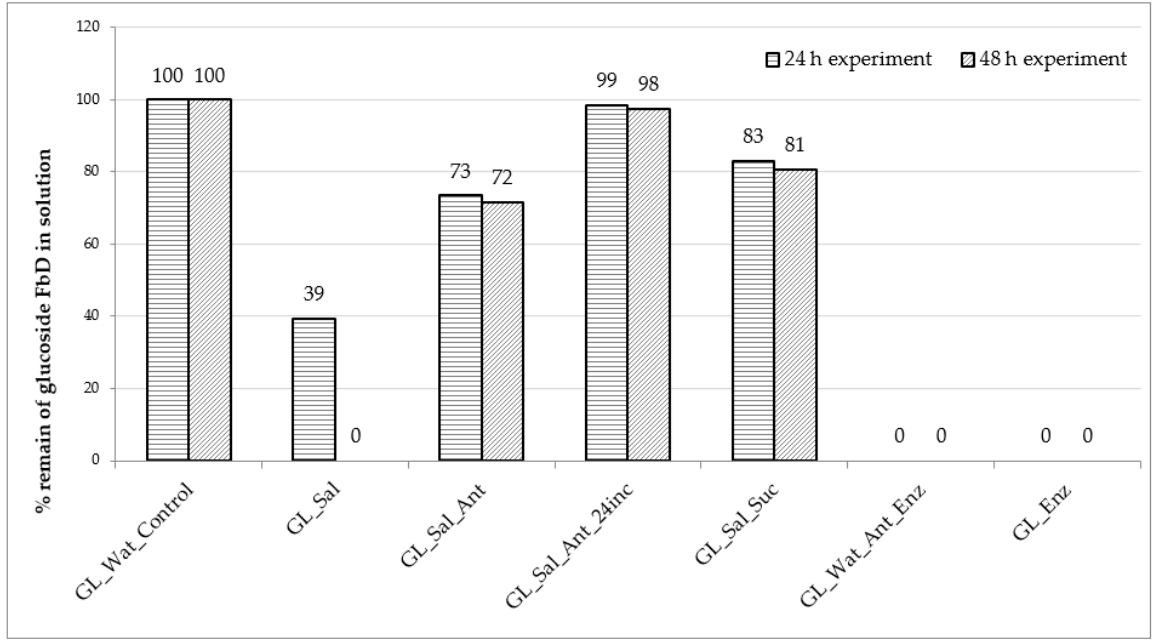
Figure 6. Changes [%] in the concentration of FbD during incubation in test solution. GL_Wat_Control-Citrusin D + water, GL_Sal-Citerusin D + saliva solution, GL_Sal_Ant-Citrusin D + saliva solution + mix of antibiotics, GL_Sal_Ant_24inc.-Citrusin D + saliva solution + mix of antiobiotic solution after incubation for 24 h Citrusin D was added, GL_Sal_Suc-Citrusin D + saliva solution + sucrose solution, GL_Wat_Ant_Enz-Citrusin D + water + mix of antibiotiocs + enzyme A. niger , GL_Enz- Citrusin D + water + enzyme A. niger